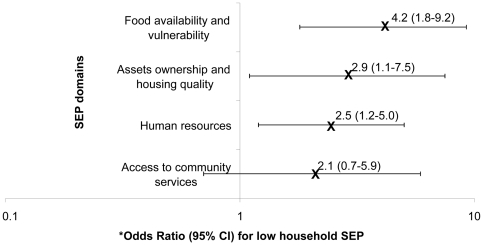
The association between household SEP domains and prevalent TB.Odd Ratios for low household SEP category and 95% Confidence intervals are plotted on a log scale. *After minimally adjusting for sex, age group and area of residence.